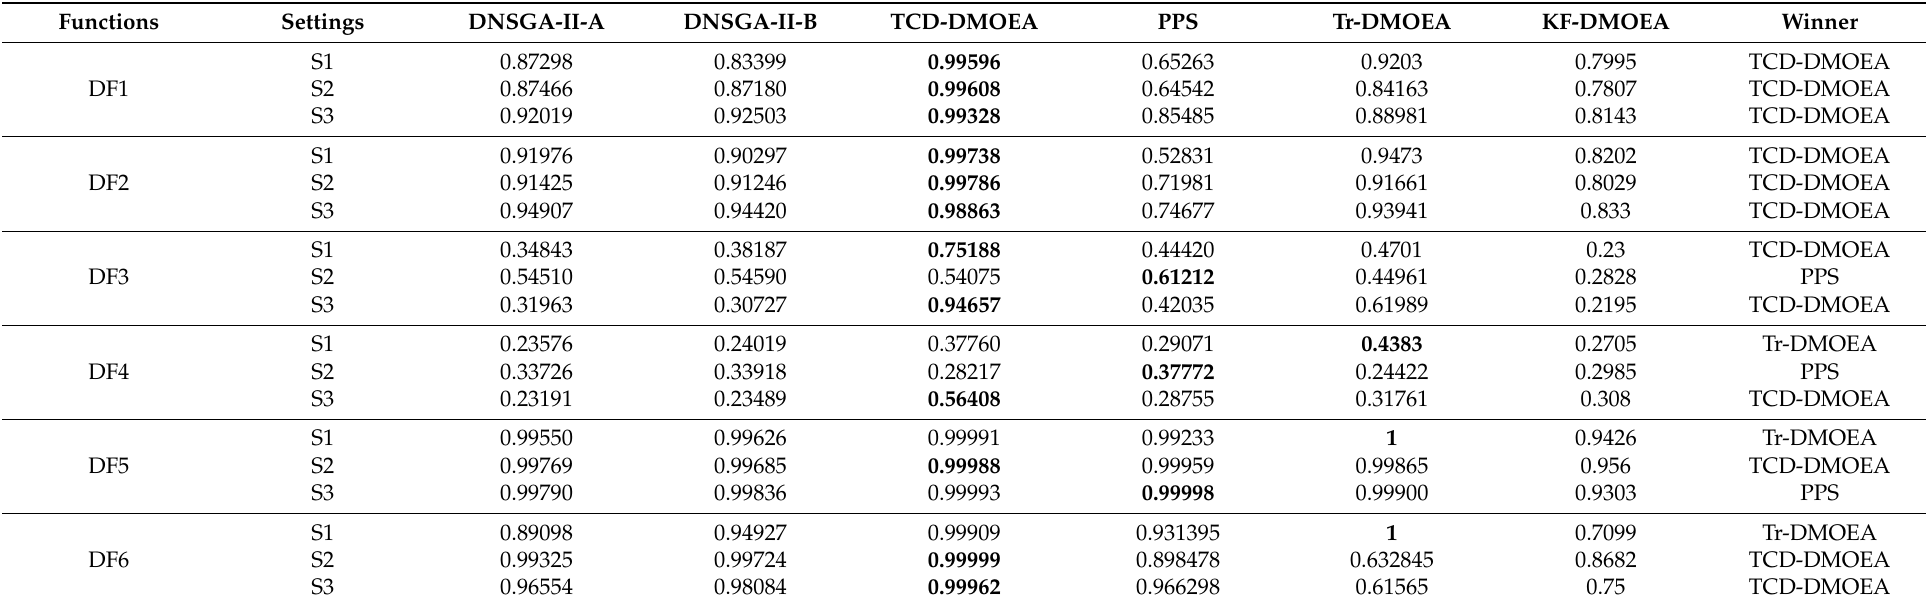
Table 3. The MS values of six comparative algorithms with different dynamic test